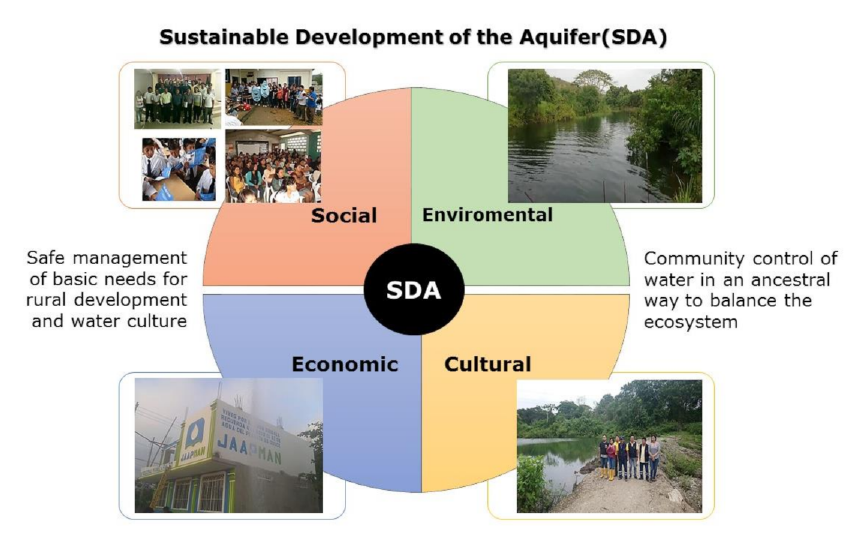
Figure 11. Relationship between environmental, economic, cultural, and social factors for the Sustainable Development of the Aquifer (DSA).